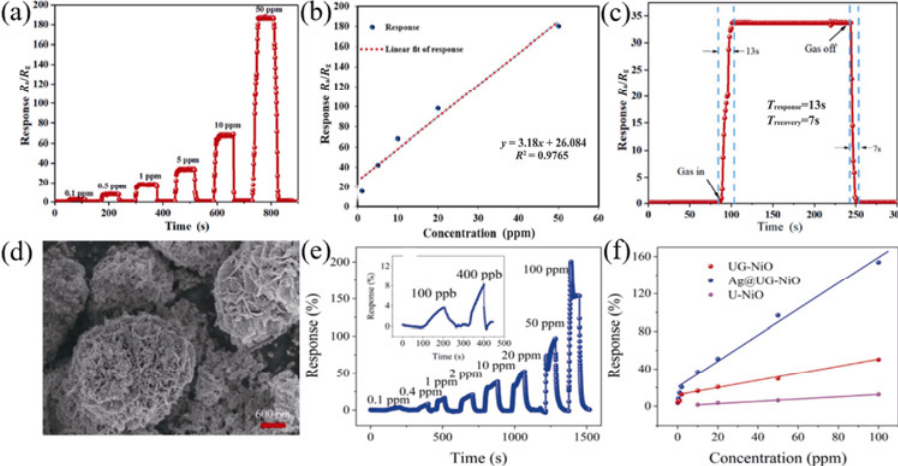
Fig. 6 (a) Response toward 2-butanone with different concentrations of 0.1–50 ppm measured at 240 ℃ . (b) Linear relationship between gas sensitivity and gas concentration. (c) Response/recovery time toward 2-butanone with 5 ppm at 240 ℃ . (d) SEM image of 3.9% Ag@UG–NiO. (e) Response of 3.9% Ag@UG–NiO to different concentrations of butanone. (f) Linear